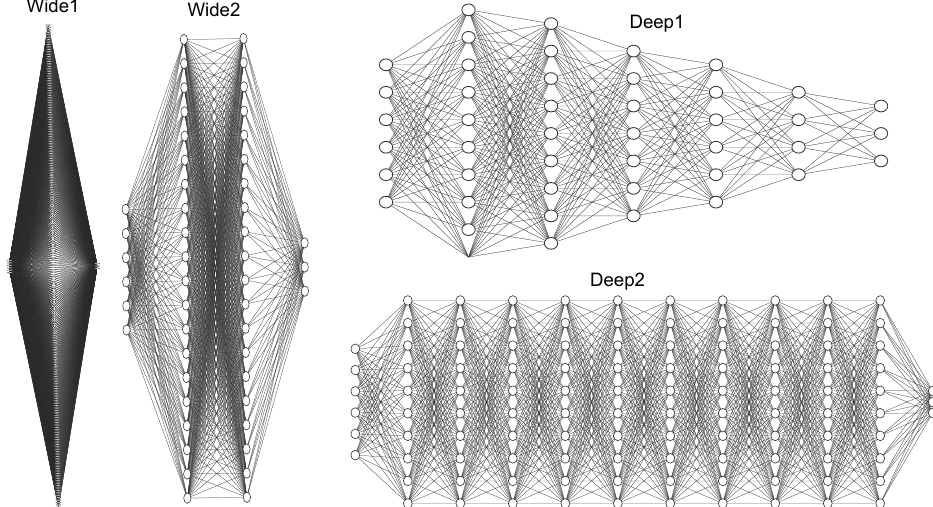
Figure 3. Network architectures for the 4 agents. All ANNs have the same 60 input and 3 output units. The number of units for the hidden layer is: Wide1 (20,000); Wide2 (2000, 2000); Deep1 (105, 90, 75, 60, 45, 30); Deep2 (100, 100, 100, 100, 100, 100, 100, 100, 100,